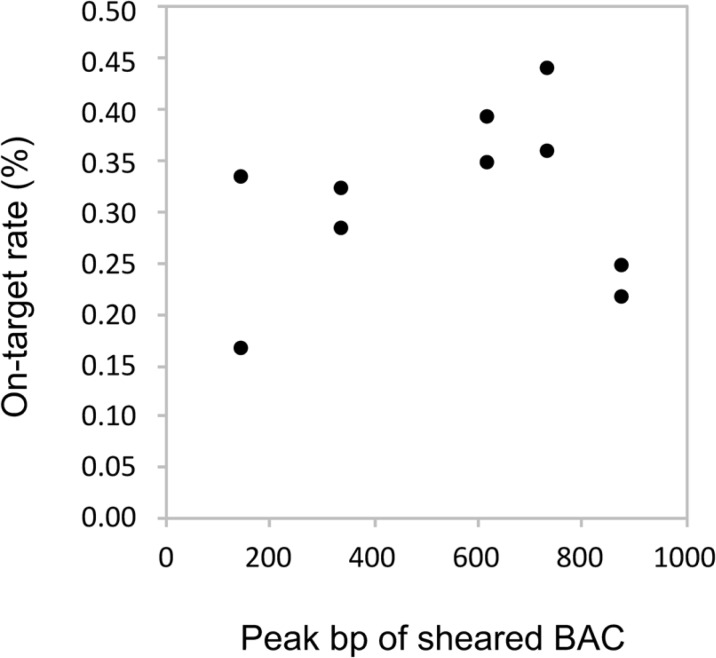
On-target rates depending on BAC baits length.On-target rate equals the reads mapped to the target region divided by the reads mapped to the whole reference genome.